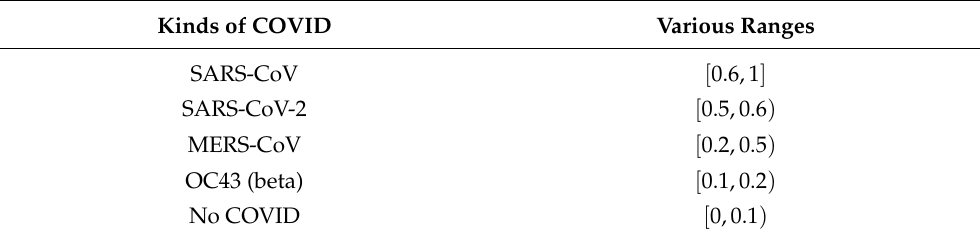
Table 2. COVID diagnosis table with